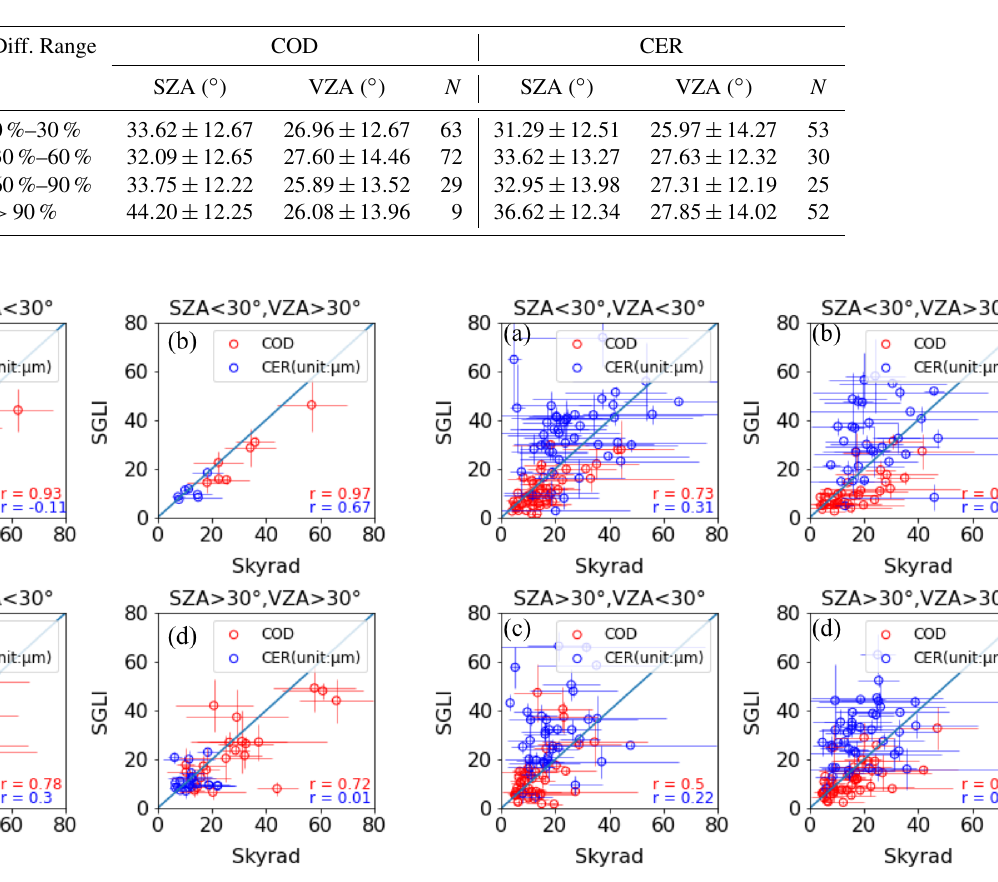
Figure 8. As Fig. 7 but for ice cloud